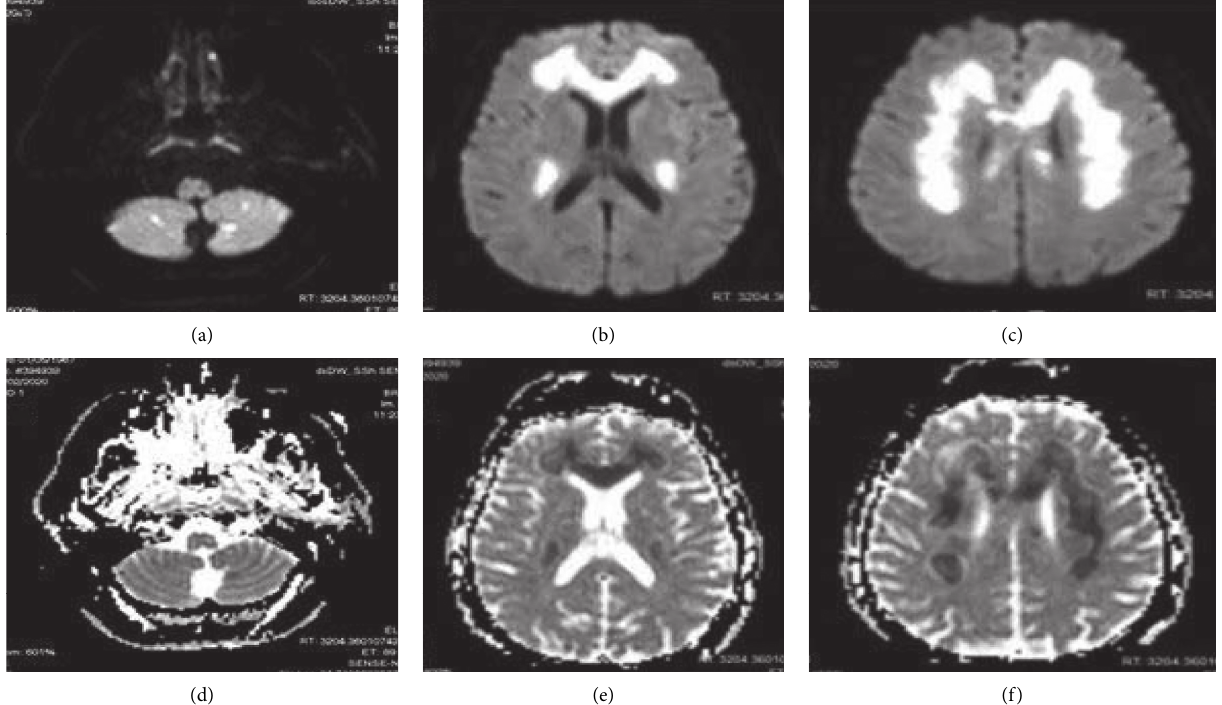
Figure 2: DWI brain MRI showing a hypersignal in the cerebellar hemisphere (a), corpus callosum (b, c), and corona radiata (c). There was a corresponding decrease of ADC values on the ADC map